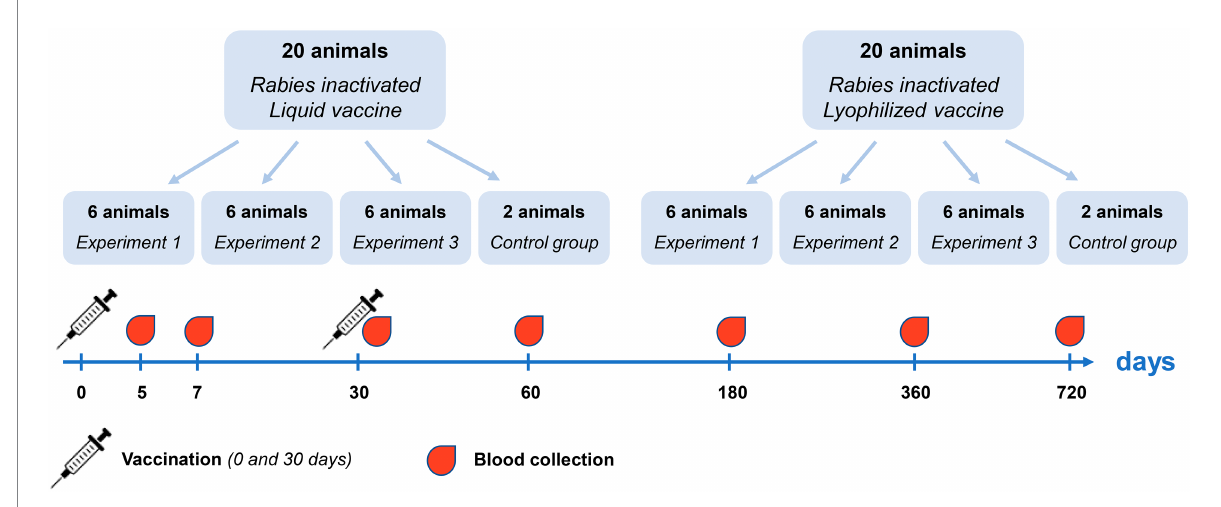
FIGURE 2 Experimental design for evaluation of immunity level following reindeer